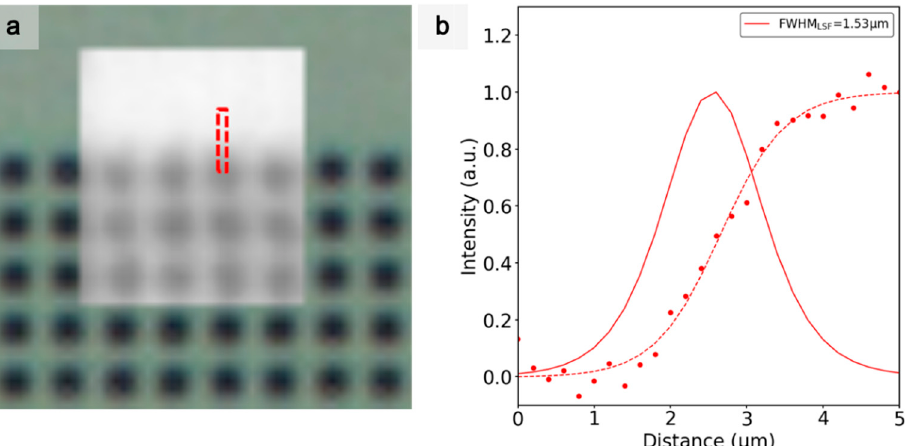
Figure 7. ( a ) Prototype of the mechanical-based microscope in comparison with a 20-cent coin. ( b ) Placement of the sample on the LED array for scanning with the mechanical-based STOM micro- scope. The operating LED had a size of 200 nm and emitted at a wavelength of 465 nm.